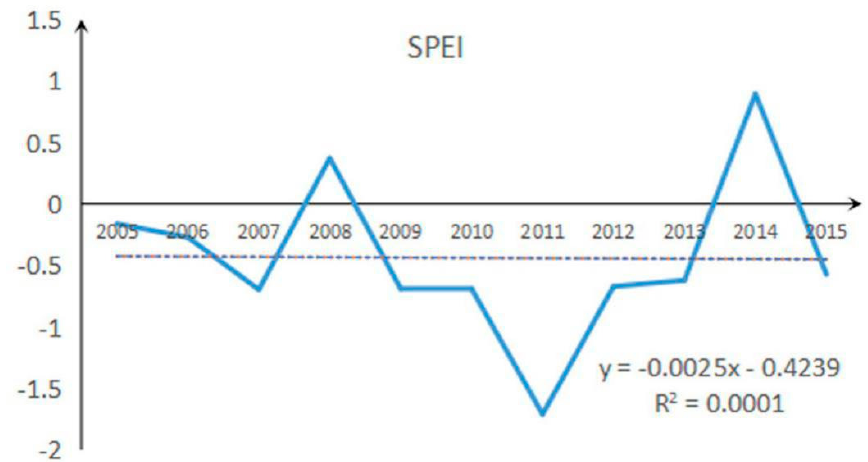
Figure 7. Standardized Precipitation Evapotranspiration Index (SPEI) and its changes during the study period.